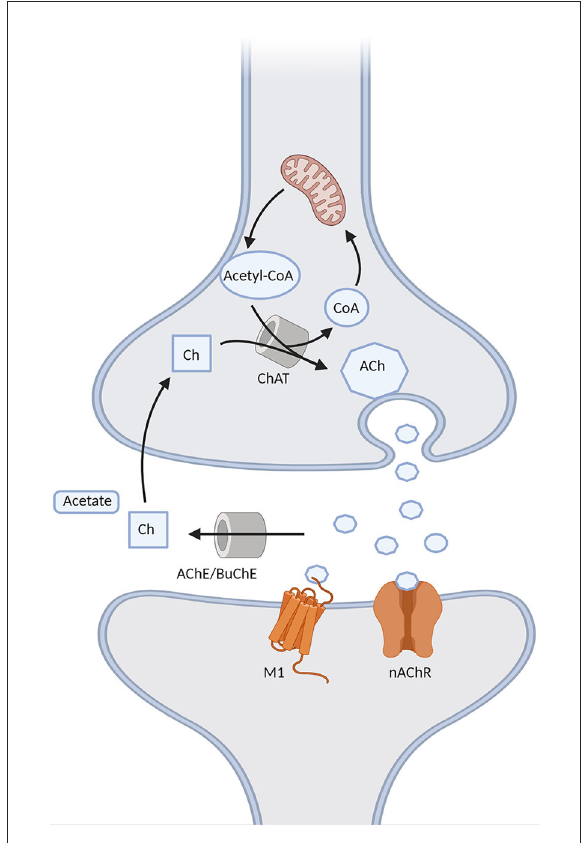
FIGURE2 Schematic representation of the cholinergic synapse.